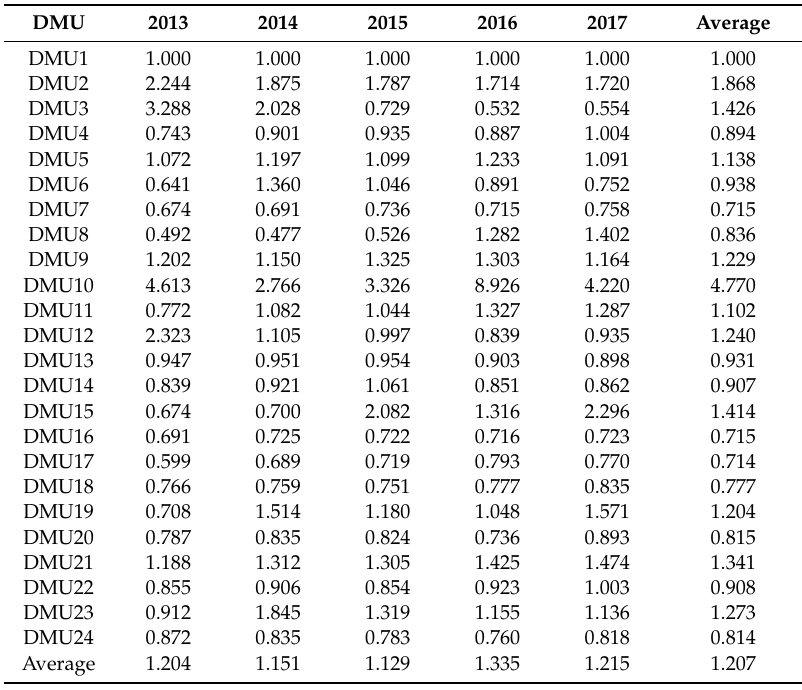
Table 2. The e ffi ciency of ICT companies